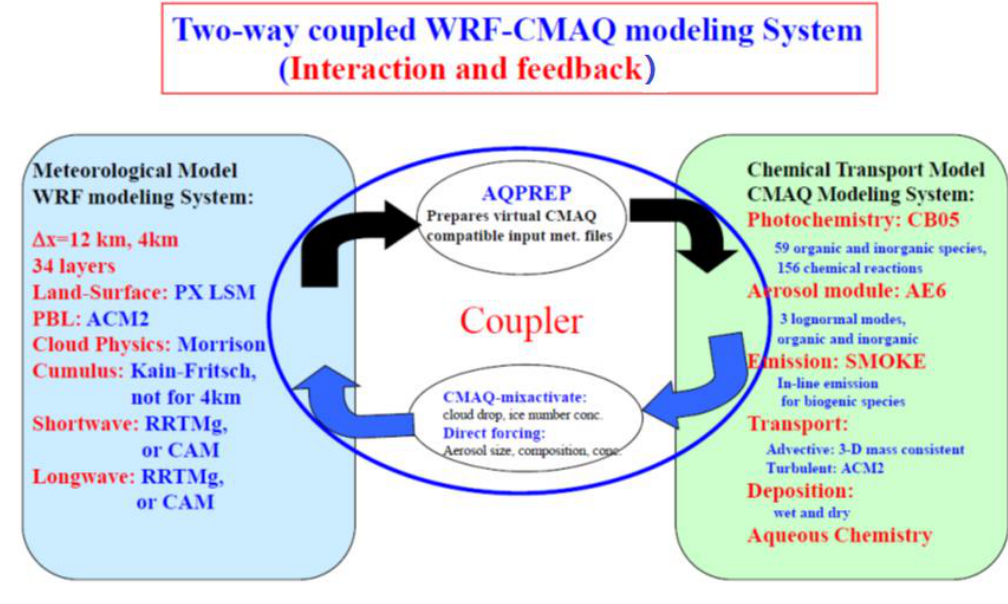
Figure 2. The two-way coupled WRF–CMAQ modeling system.